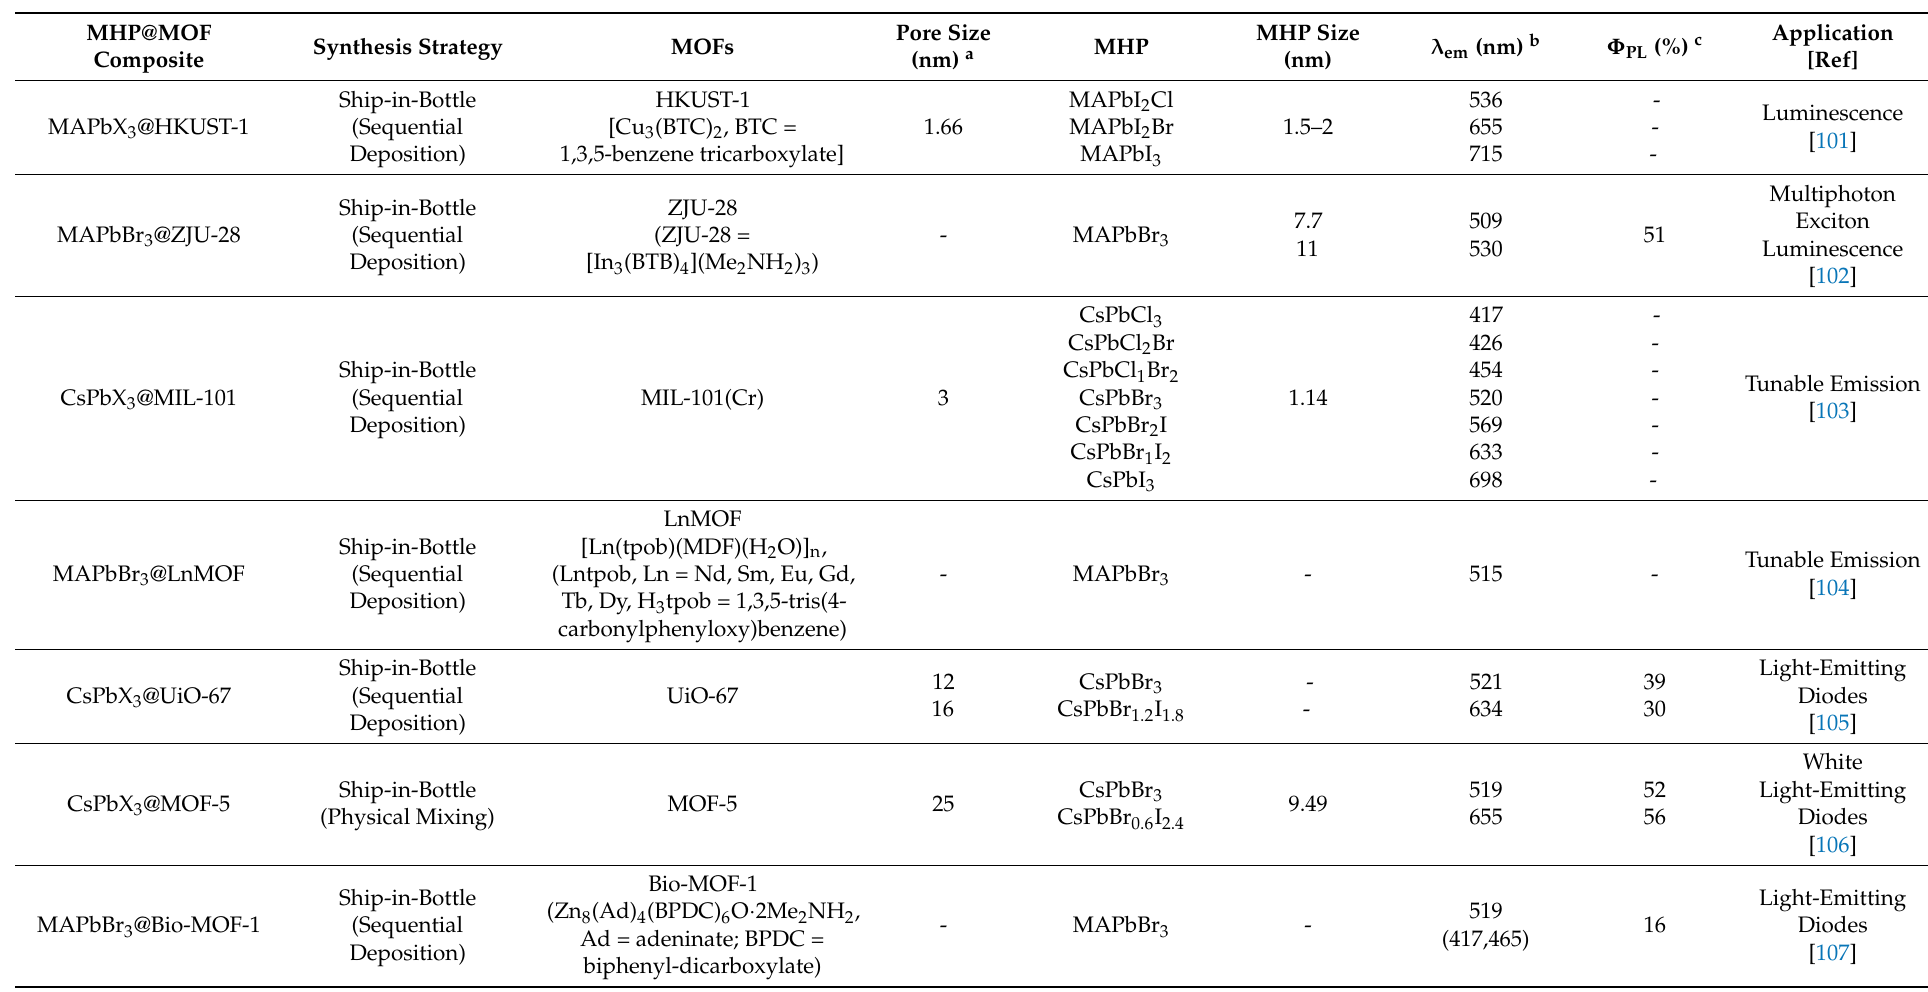
Table 1. Summary table of the composition, synthesis methodology, structural and optical properties, and applications of the MHP@MOF